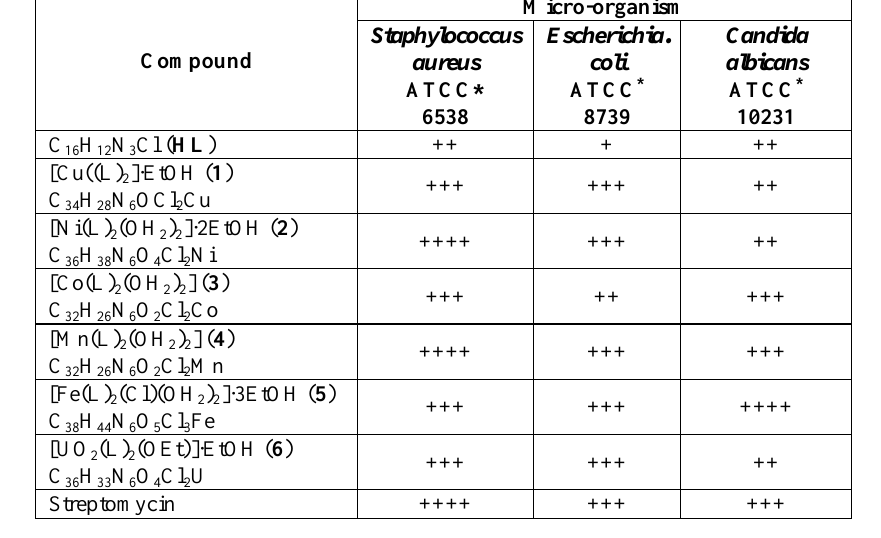
Table 6. Antimicrobial activity of the Schiff base ligand and its metal complexes.